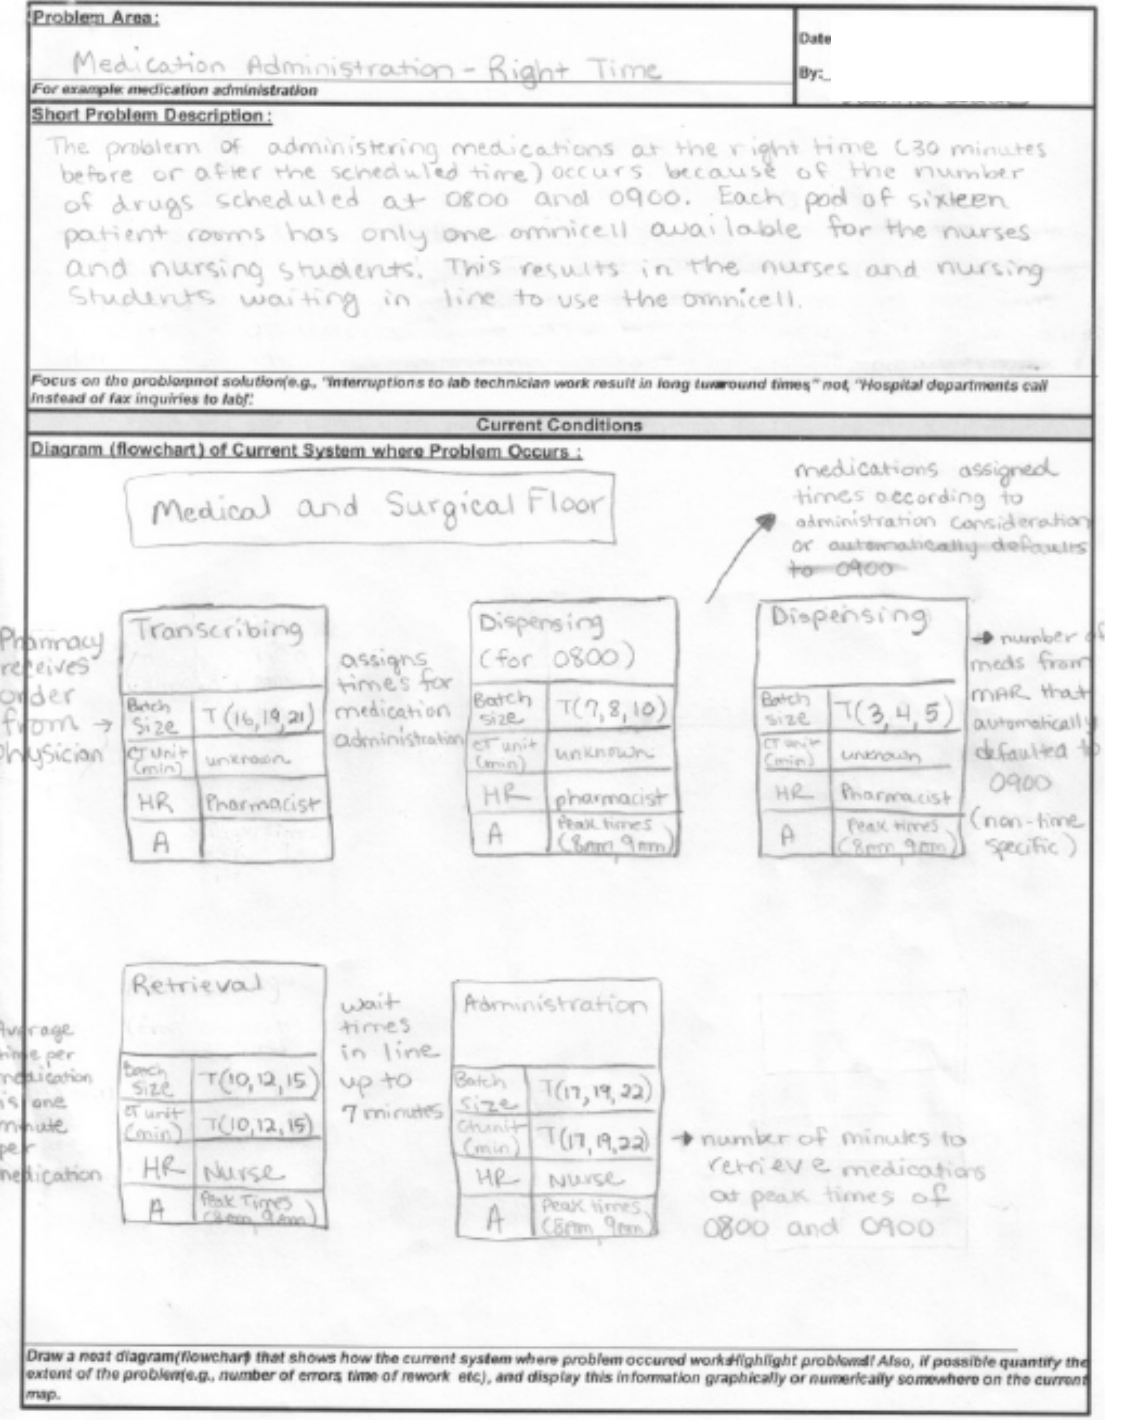
Figure 3a. “Example of Completed Map to Improve